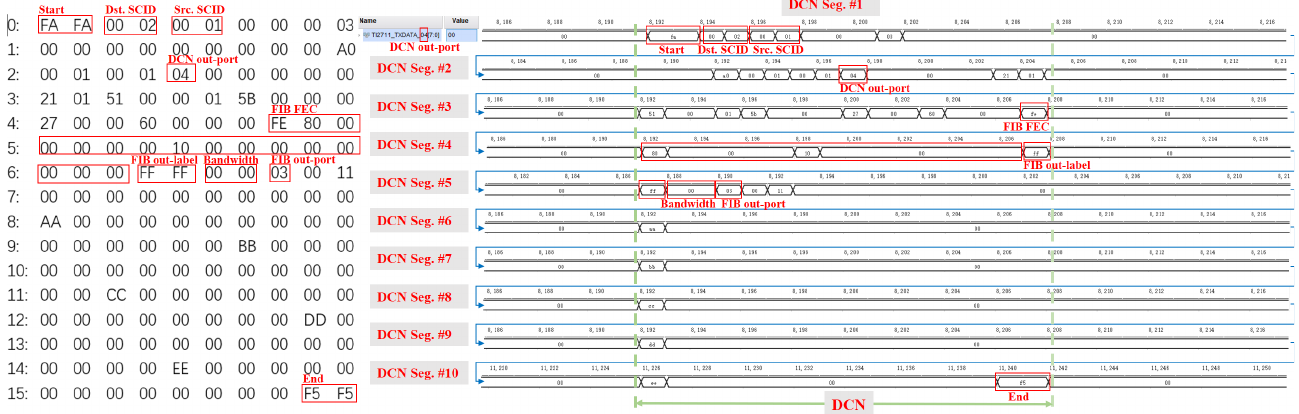
Figure 17. A data communication network sequence diagram for a managing and controlling message, i.e., static FIB, from node vx_simulator_01 (SCID 1) to node vx_simulator_02 (SCID